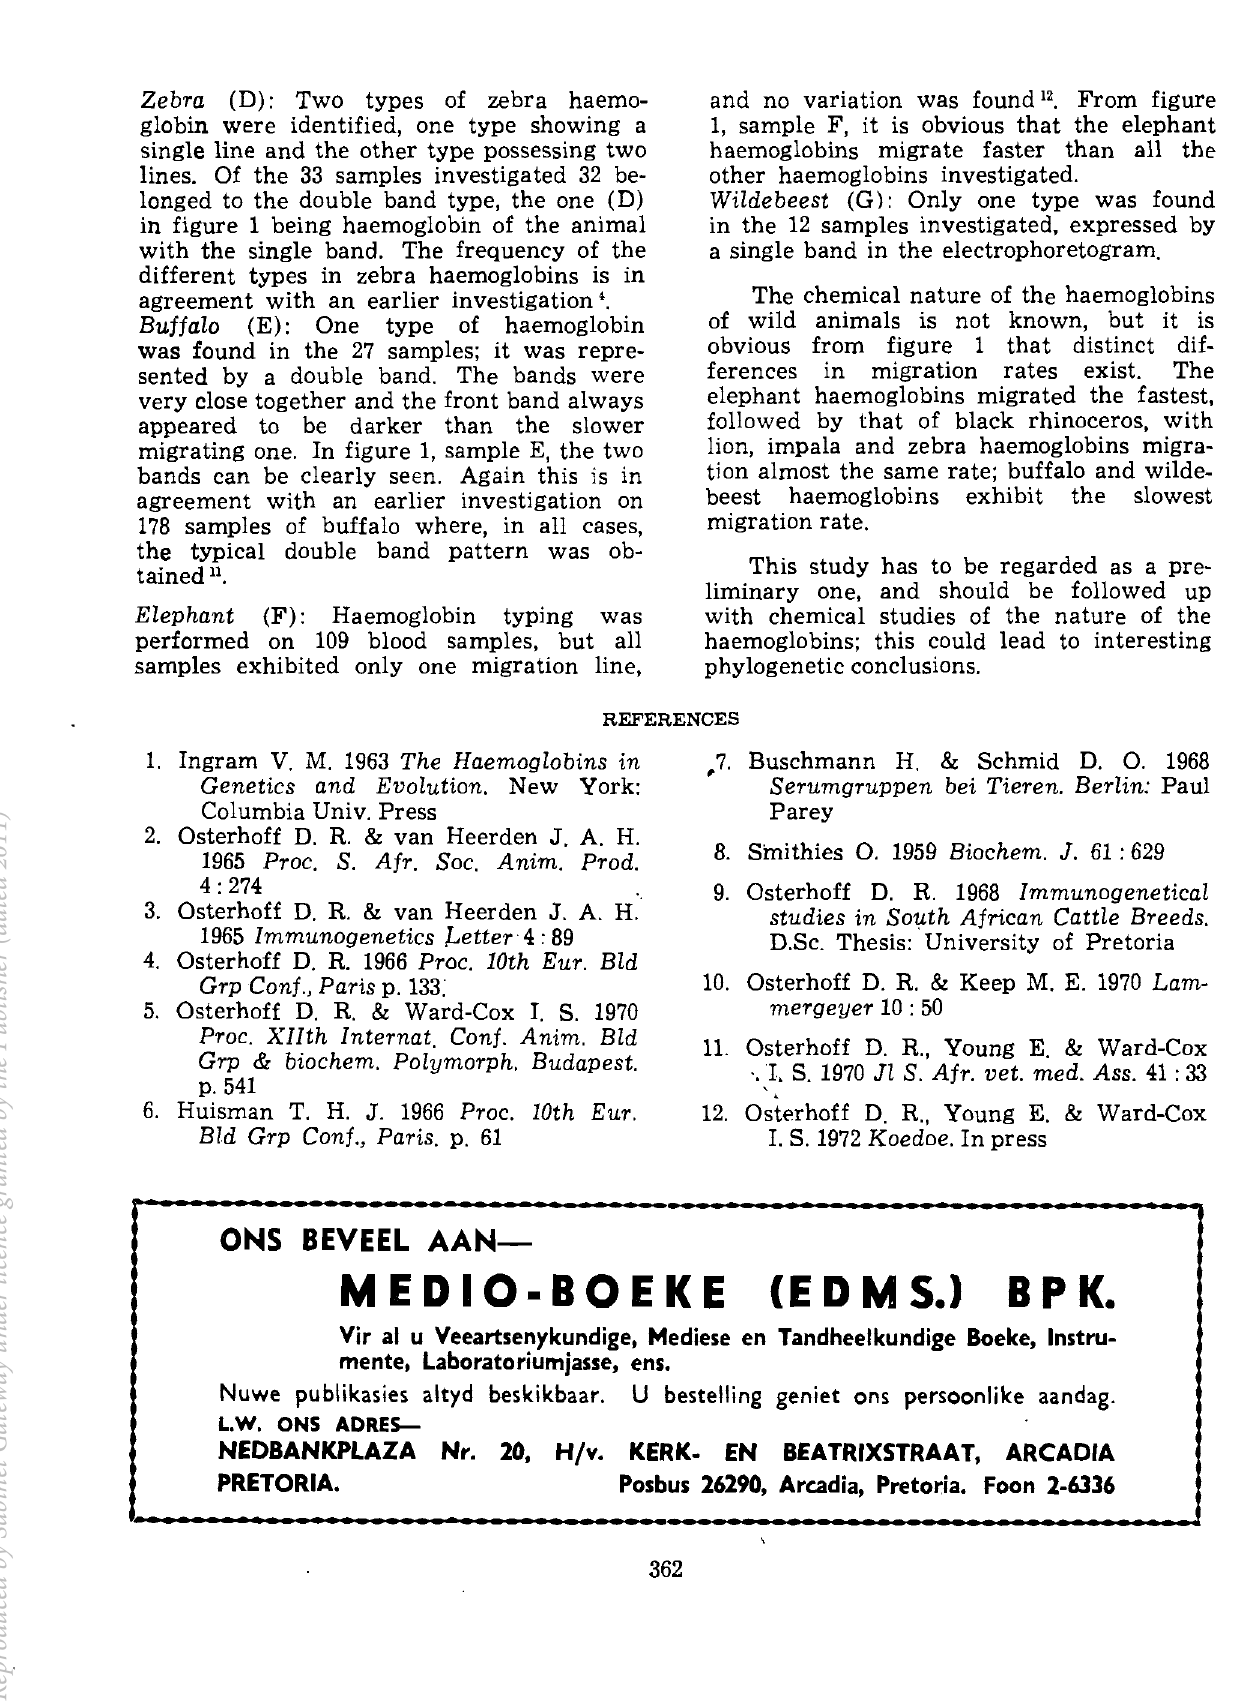
and no variation was found 12. From figure 1, sample F, it is obvious that the elephant haemoglobins migrate faster than all the other haemoglobins investigated. Wildebeest (G): Only one type was found in the 12 samples investigated, expressed by a single band in the